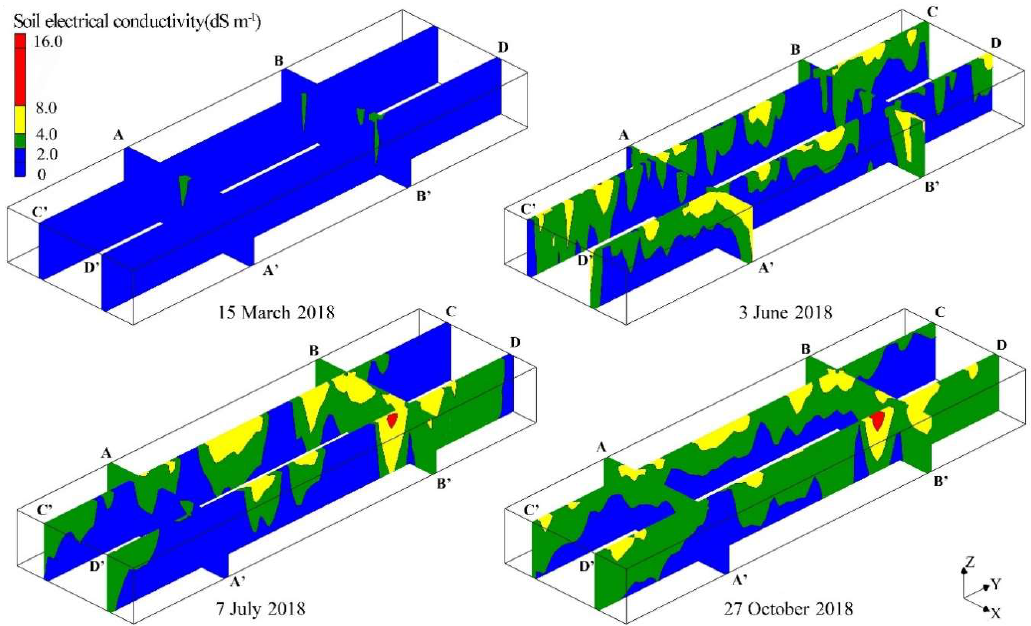
Figure 4. Cross sectional view of the distribution of soil salinity in three-dimensions at different periods.